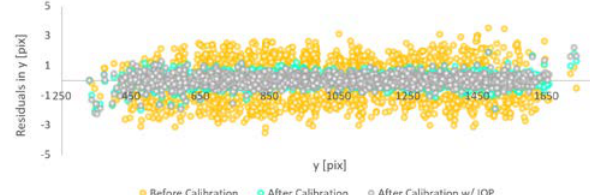
Figure 10: y-image residuals as a function of their row number in the image